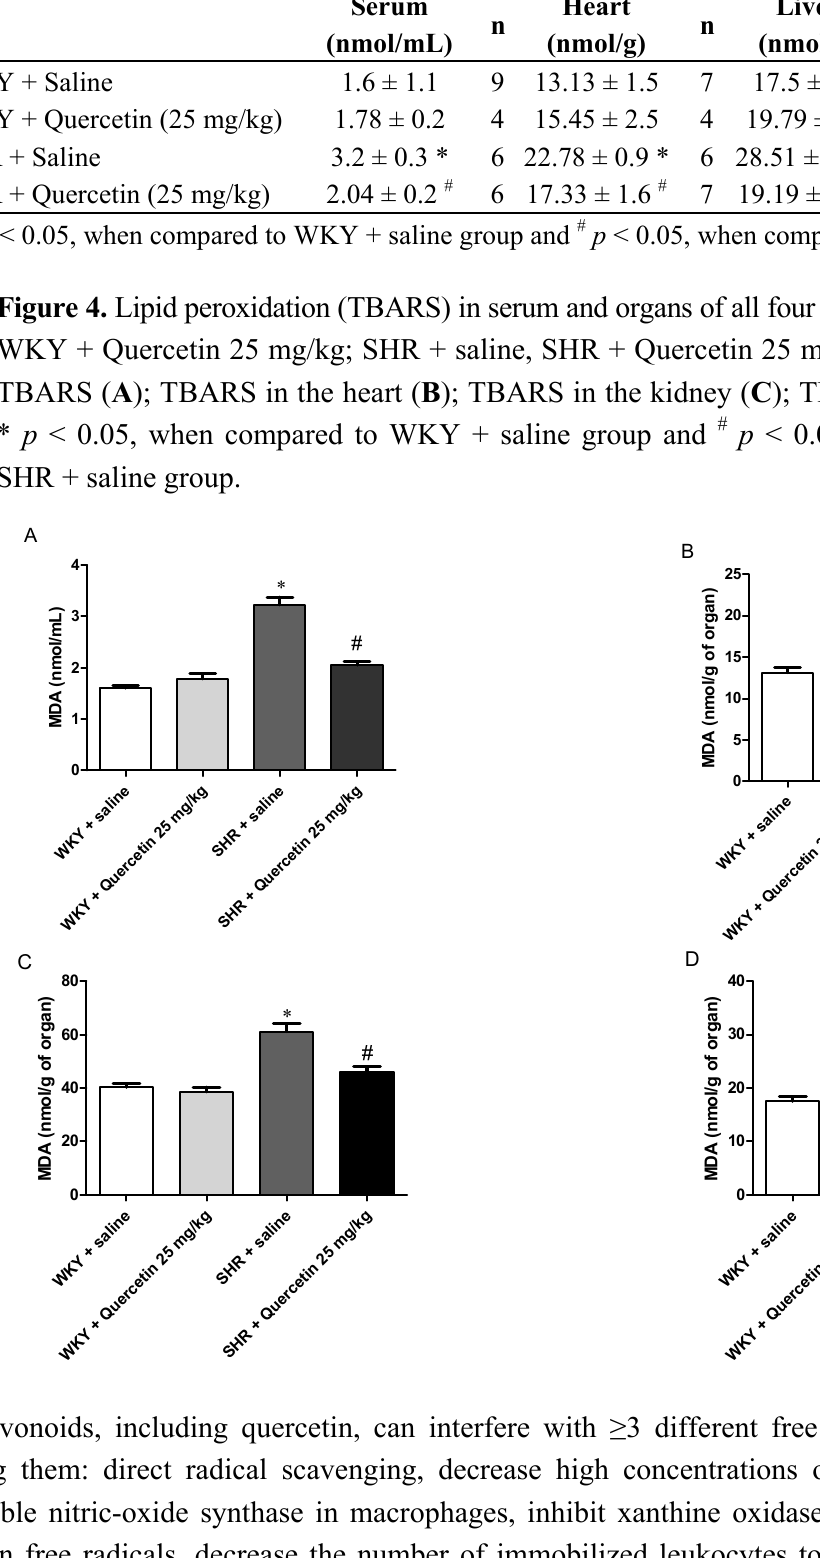
Kidney Liver Heart Serum n n n n (nmol/g) (nmol/g) (nmol/g) (nmol/mL)